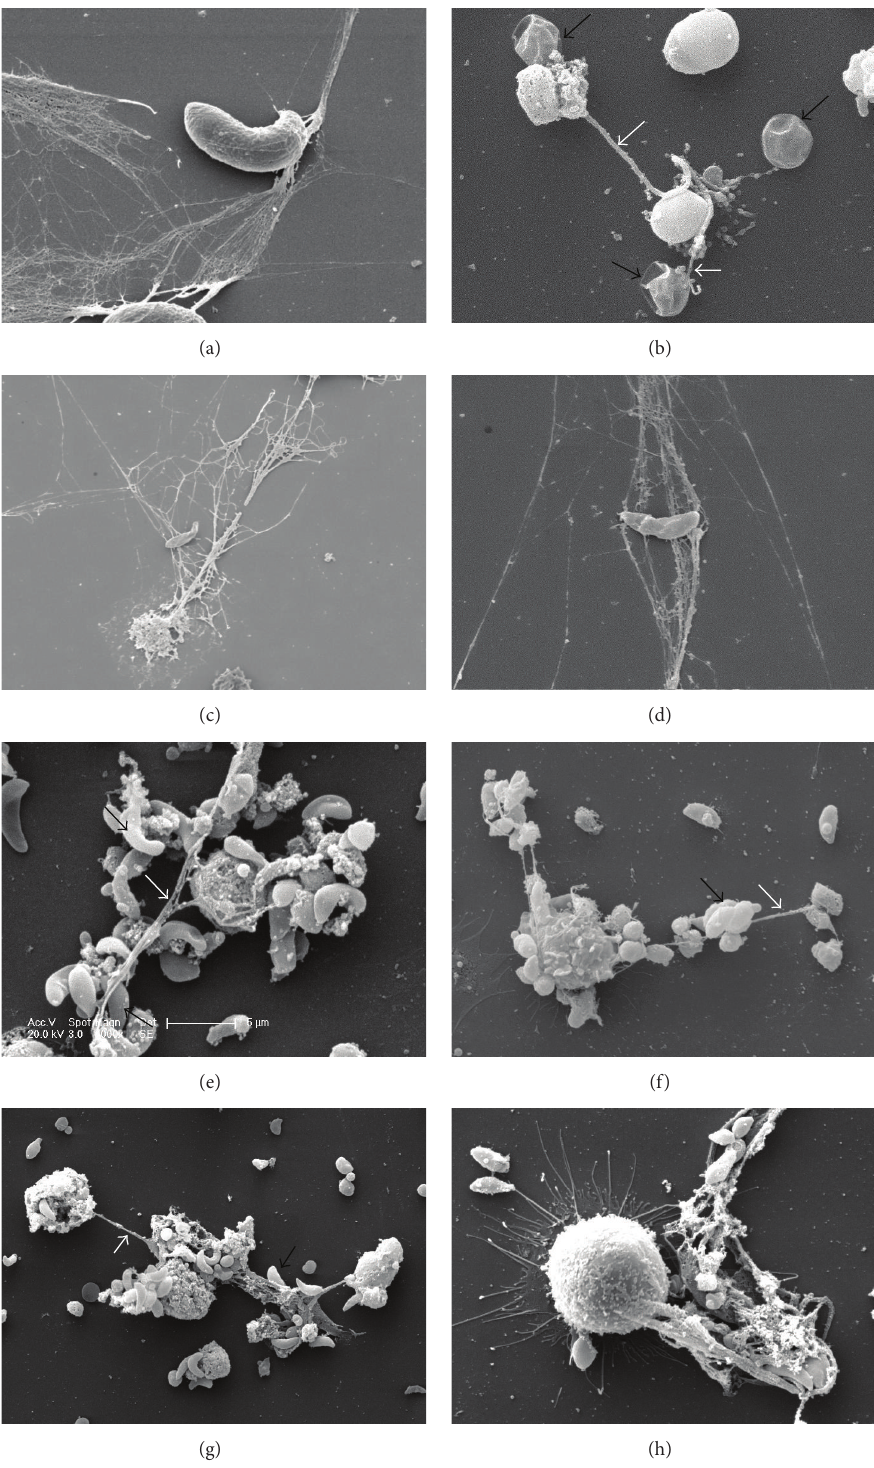
Figure1:ETosisisnotaparasite-norastage-specificcelldeathprocess(SEManalysis).(a) Eimeriabovis sporozoite-triggeredbovineNETosis; (b) Cryptosporidiumparvum oocysts(backarrows)inducedNETosis(whitearrows);(c) Toxoplasmagondii tachyzoitesentrappedbyadelicate DNA fibre derived from bovine PMN; (d) Toxoplasma gondii tachyzoite completely entrapped in filigree NET structures; (e) PMN-derived NETs (white arrow) after Besnoitia besnoiti tachyzoites encounter (black arrows); (f) Neospora caninum tachyzoites (black arrow) trapped in bovine NETs (white arrow); (g) monocyte-derived extracellular traps (METs) forming spread (white arrow) ETs entrapping Besnoitia besnoiti tachyzoites (black arrow); (h) Besnoitia besnoiti derived thick and thin